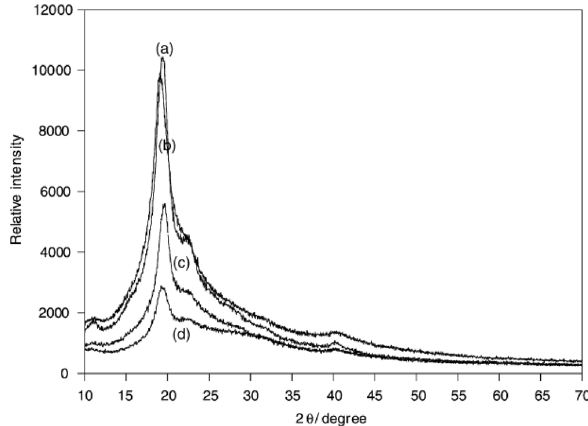
Fig. 4 The XRD spectra of PVA/PECH/KI blend solid PEs ( a ) pristine PVA ( b ) PVA/ PECH with 1:0.2 ratio, c PVA/PECH with 1:0.5 ratio, and d PVA/PECH with 1:1 ratio